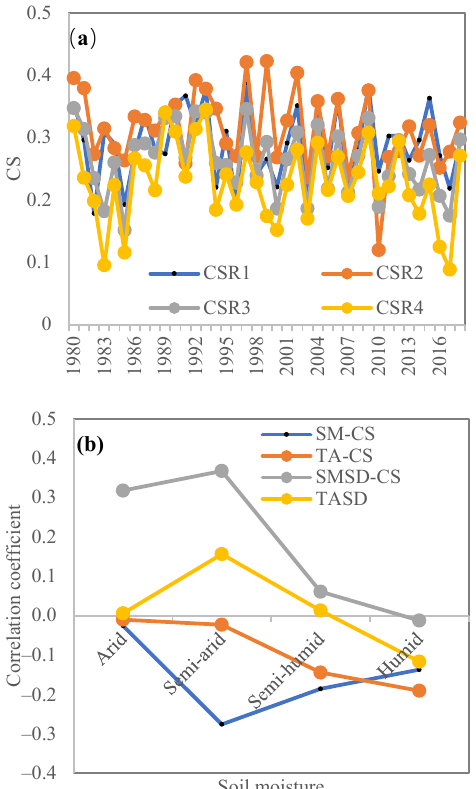
Figure 13. Inter-annual variation in warm season ( a ) soil moisture, ( b ) standard deviation (standard deviation of monthly data within warm season of a year) of soil moisture, ( c ) temperature, and ( d ) standard deviation of temperature under different dry-wet climatic backgrounds.